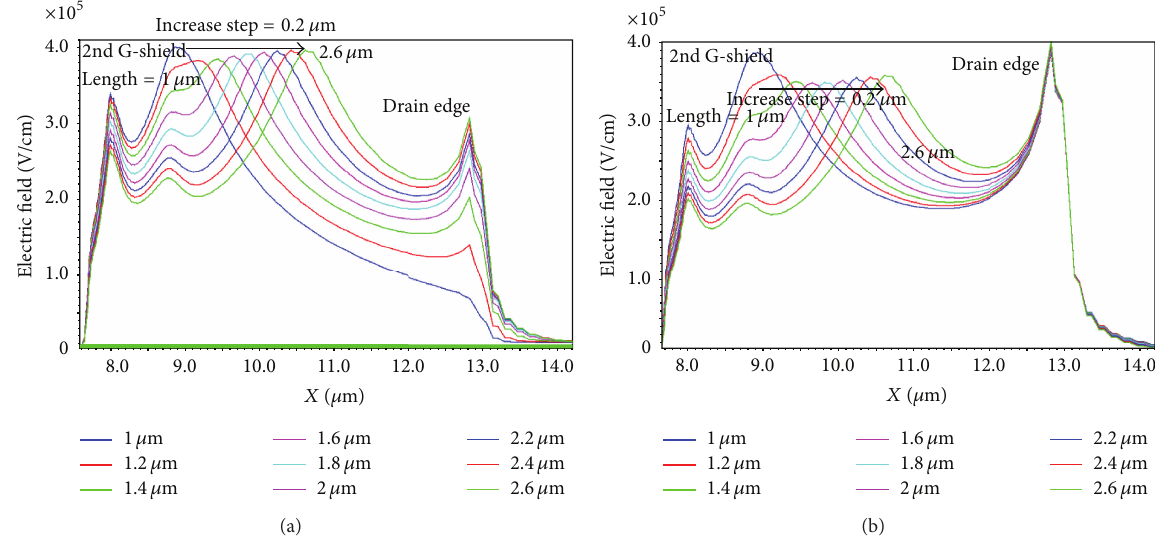
Figure 5: For (a) a high implant dose of 1.8𝑒12 cm −2 and (b) a low implant dose of 1.4𝑒12 cm −2 , the crucial electric field distribution along the surface of the N-drift region is determined by the length of the 2nd G-shield.